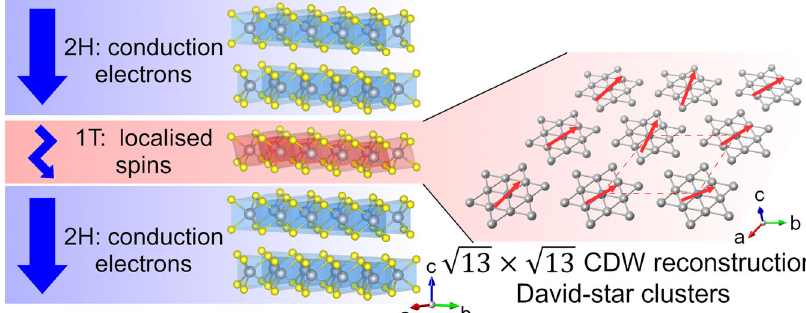
Fig. 5 1T-NbS 2 inclusions in 2H-NbS 2 . Schematic visualisation of the proposed interpretation of the observed out-of-plane charge transport anomaly. The 2H-NbS 2 crystal (structure in the centre) contains inclusion layers of 1T-NbS 2 (highlighted in red). 1T-NbS 2 undergoes a ffiffiffiffiffi p ffiffiffiffiffi p ´ 13 13 charge-density-wave (CDW) reconstruction. The Nb atoms in the CDW state are arranged into David-star-shaped clusters, superlattice of which is depicted on the right (only Nb atoms are shown, the dashed line marks the unit cell after the reconstruction). Each cluster contains an unpaired localised spin at the centre (red arrows on the right). The orientations of spins in the illustration are arbitrary and are not meant to suggest any particular ordering. This array of localised magnetic moments causes the itinerant electrons in the 2H-NbS 2 bulk to experience Kondo scattering during the out-of-plane current fl ow (blue